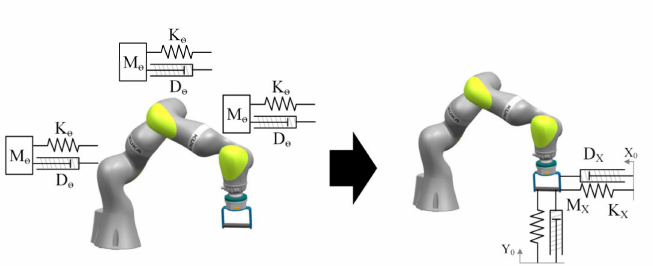
Figure 4. Schematic diagram of the transformation from the joint space impedance control model to the Cartesian space impedance